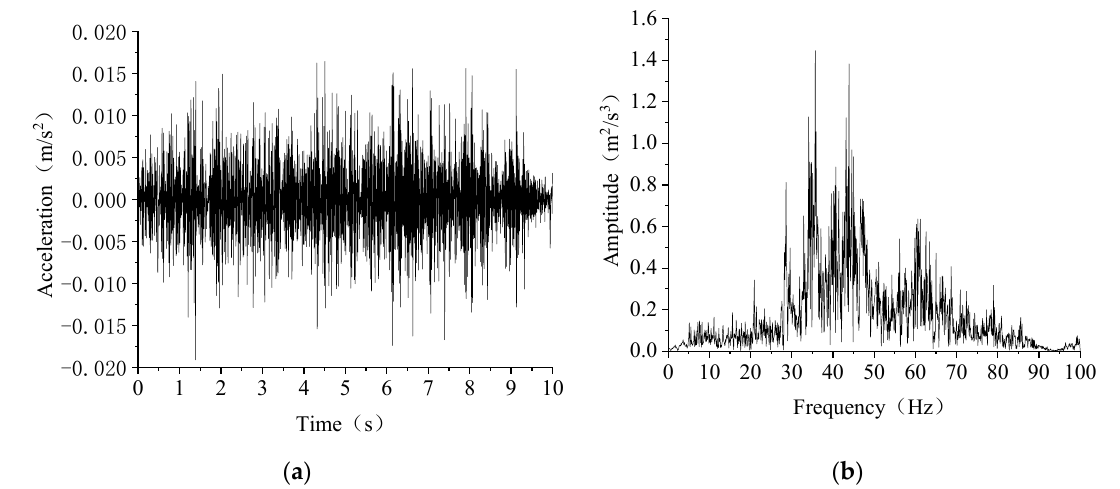
Figure 12. Vertical acceleration curve: ( a ) time history; ( b ) spectra. From the spectra curve of the metro vibration, the energy of metro vibration is shown to be mainly concentrated in the range of 20 Hz to 50 Hz, which is consistent with the research results [23]. In order to cover the main frequency band 30 Hz to 50 Hz in the analysis and to consider the low-order vibration mode of the building, the two frequency points of 1 Hz and 50 Hz are used to determine these two coefficients. Therefore, the damping coefficient is: α = 0.3696 Hz, β = 1.872 × 10 − 4 s. Considering that vibration caused by the metro is microvibration and the structure is in the elastic state, the elastic material model has been used in the entire finite element analysis. The beam–column element is simulated by the frame element. The floor element is the shell element. Under slight vibration, the damping ratio of concrete can be taken as 0.03 [24]. In addition to its simplicity, the Rayleigh damping structure also satisfies orthogonal conditions. SAP2000 has developed the “Damping-Friction Spring” unit for the widespread application of friction springs at this stage. Its damping model is based on the viscoelastic model of Maxwell, and its nonlinear force–deformation relationship is [25]: where f ( t ) is the unit force, c ( t ) is the controllable damping constant (positive) and ∆ t is the damper deformation. As is shown in Formula (6), the unit dissipates energy based on displacement (independent of speed) [26], which is specifically manifested as internal friction related to the deformation during loading and unloading. The nonlinear force–deformation relationship is shown in Figure 13.